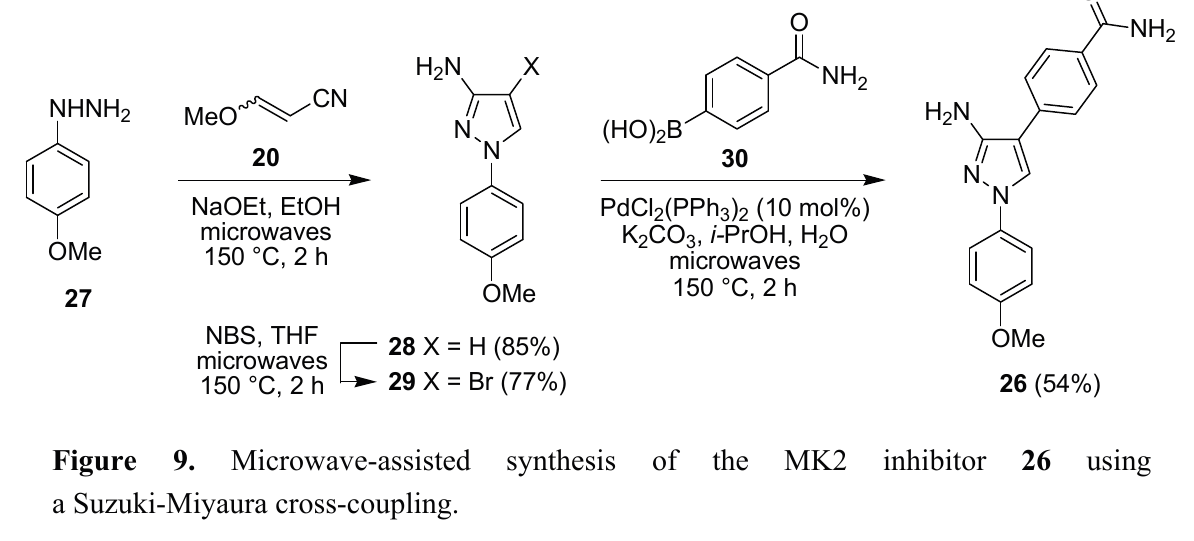
Figure 9. Microwave-assisted synthesis of the MK2 inhibitor 26 using a Suzuki-Miyaura